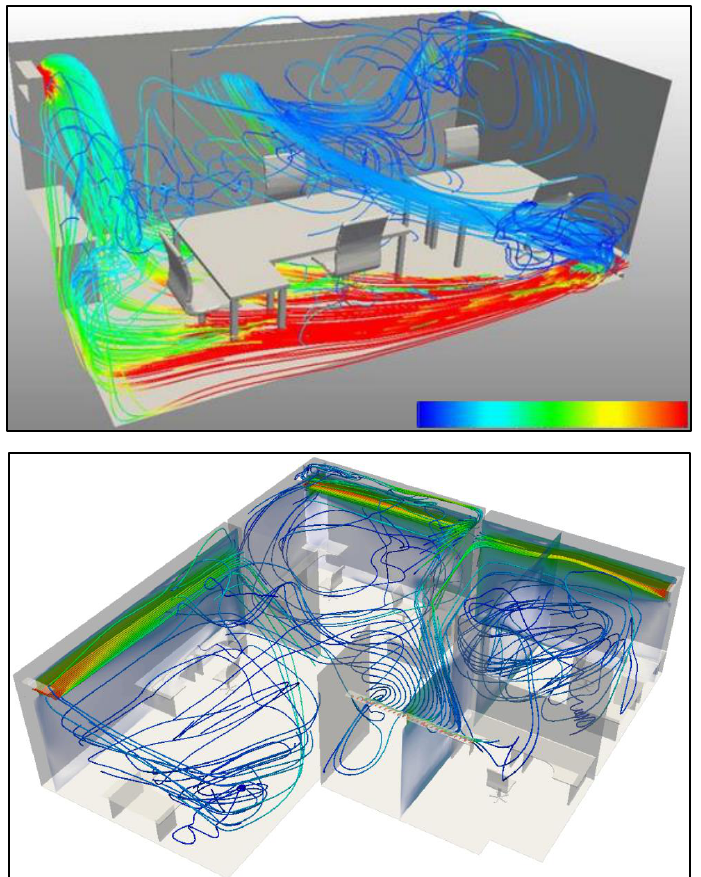
Figure 1. Visual representation of airflow streamlines in a meeting room (left) and office space (right) colored to velocity magnitude from low (blue) to high (red). The convection pattern in the meeting room demonstrates how the infection can be persistently carried by the airflow between two chairs separated by 6 feet. The convection pattern in the office space illustrates how the infection can be taken by the airflow from one cubicle to the other. Simulation by SimScale